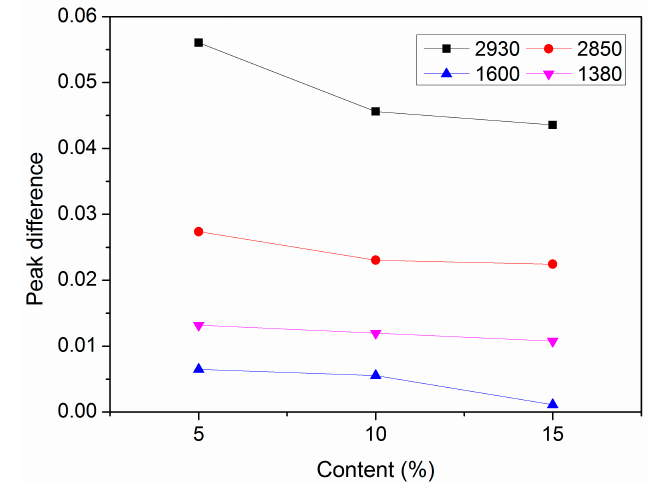
Figure 6. Peak value differences after aging versus diatomite content for functional groups.